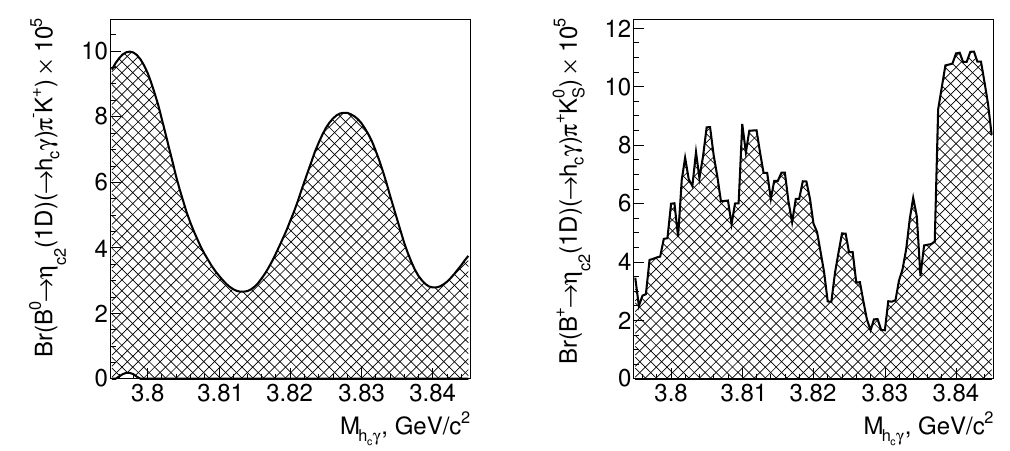
Figure 8 . Con(cid:12)dence intervals (90% C.L.) for the branching-fraction products for the channels B 0 (cid:17) c 2 (1 D ) (cid:25) (cid:0) K + (left) and B + !